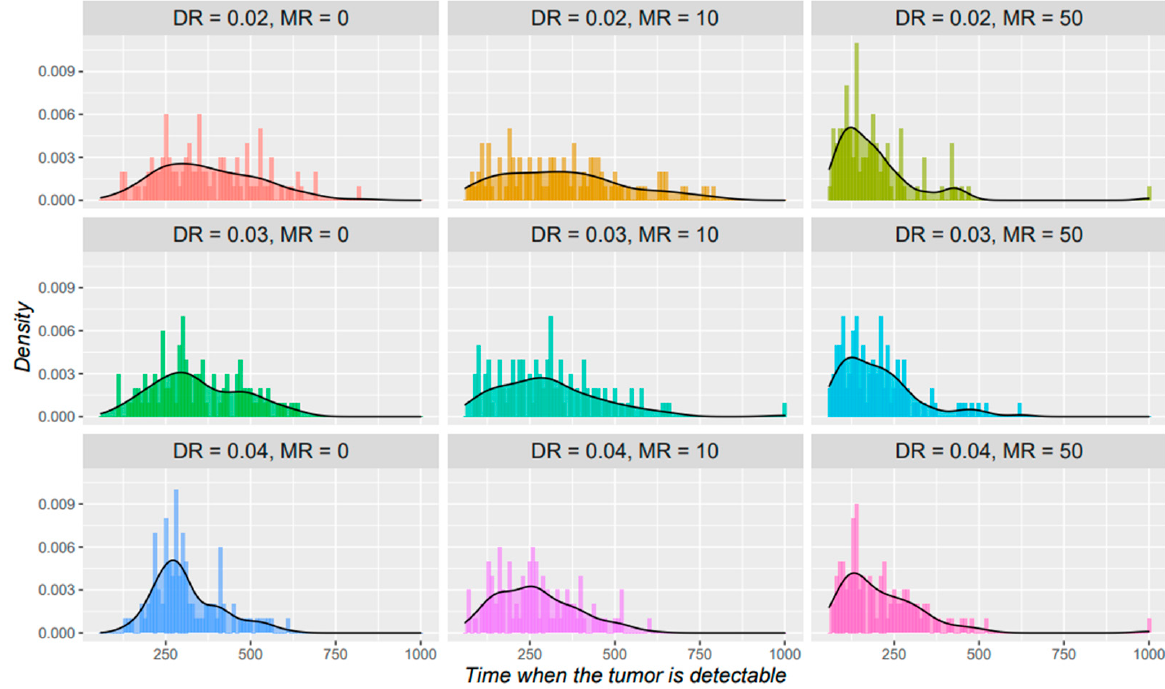
Figure 7. Time distribution when tumor reaches a detectable size. The x axis indicates the time when the tumor size reaches 10,000, the y axis indicates the density for each binned time periods. Each panel represents for a different initial setting of the parameters.